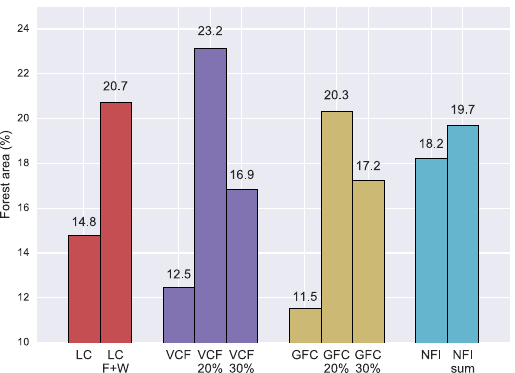
Figure 7. The total forest area in China with different forest definitions at the beginning of 2000s. The number on top of each bar is the total forest area represented as national forest coverage (%). For MODIS LC, forest was defined by the five IGBP forest land cover types in the product, and woody savanna was also included as a modified definition (LC F + W). For MODIS VCF and GFC, forest was defined by fractional tree cover (VCF, GFC) or by the binary tree cover using the 20% (VCF 20%, GFC 20%) and 30% (VCF 30%, GFC 30%) thresholds. Forest area was calculated as the areal sum of all non-zero fractional tree cover (numeric) in MODIS VCF and GFC, or the areal sum of forest pixels in MODIS LC and in the binary VCF and GFC. For NFI, forest was defined as woodland with canopy coverage > 20%. The total forest area was the value reported in the 6 th NFI. The NFI sum gives the total forest area summed up from the provincial numbers in the 6 th